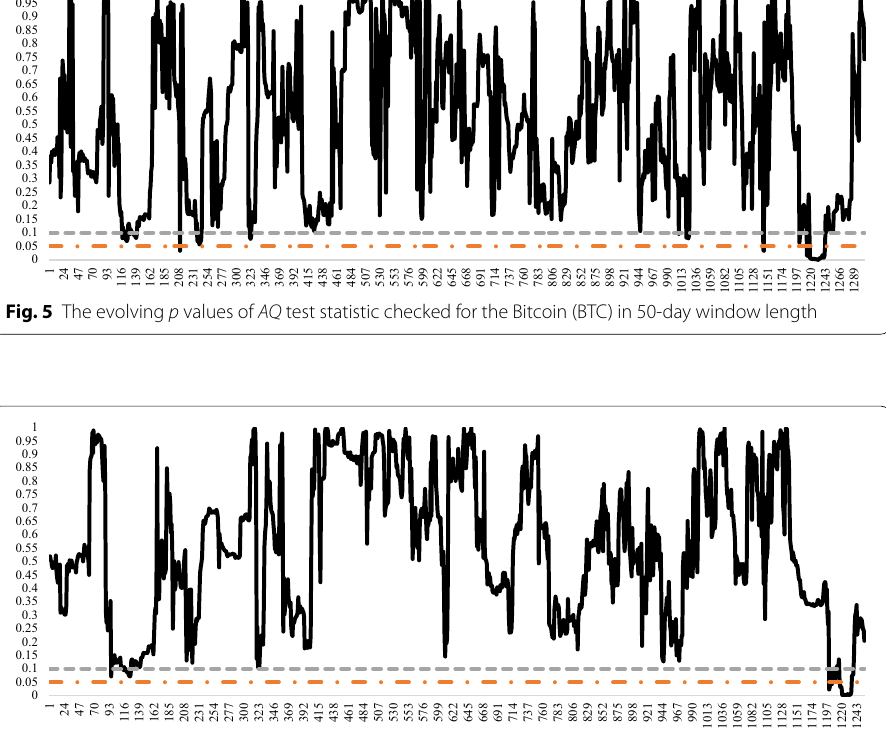
Fig. 6 The evolving p values of the AQ test statistic checked for the Bitcoin (BTC) in 100-day window